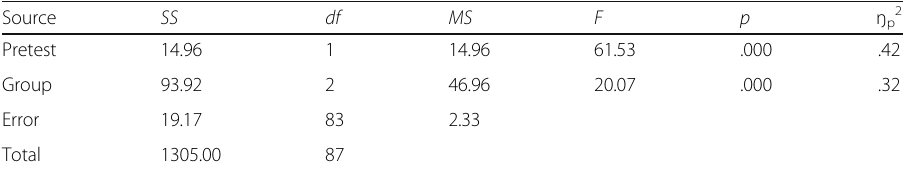
Table 10 Results of one-way ANCOVA for untimed grammaticality judgment test Source SS df MS F p ŋ p 2 Pretest 14.96 14.96 Group 93.92 Error 19.17 Total